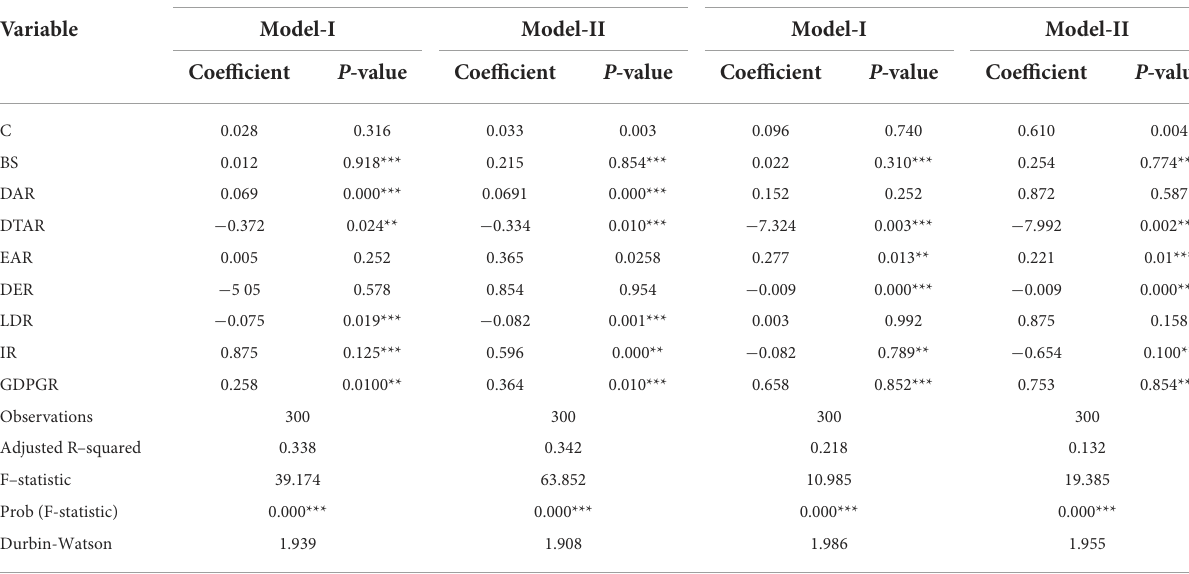
TABLE 9 The results of the random effects estimation as measured by ROA and ROE for bank